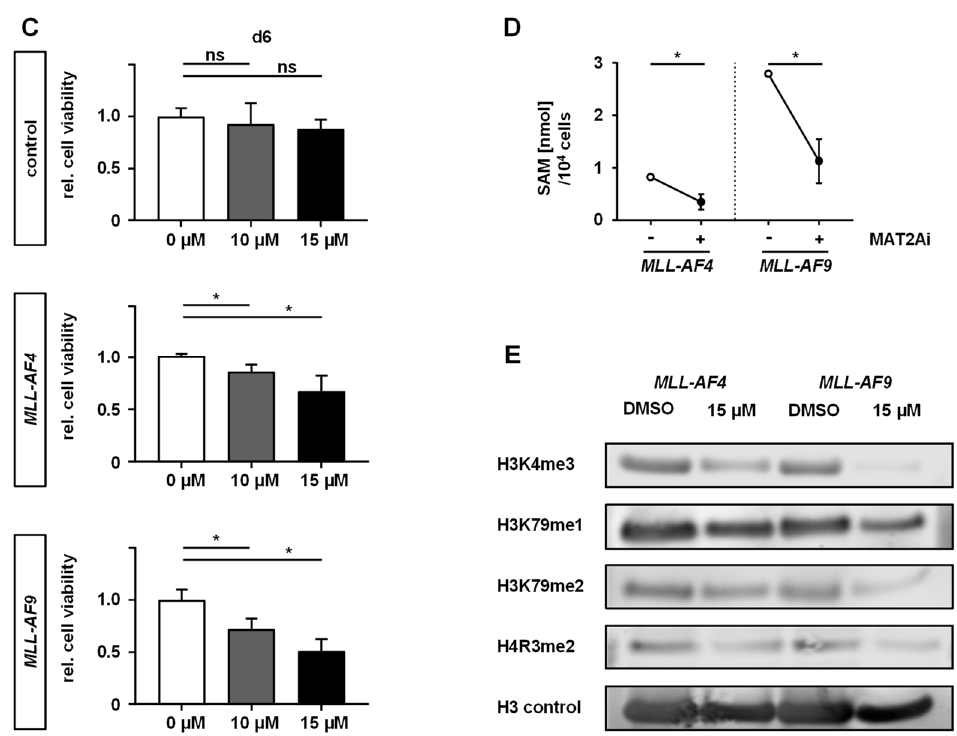
Figure 2. MAT2A inhibition impairs the proliferation and viability of MLL r cells, resulting in reduced SAM levels and histone methylation. ( A ) MLL-AF4 / -AF9 or culture-expanded CD34 + huCB control cells were treated with increasing concentrations of PF-9366 or vehicle (DMSO) for 6 days and the relative cell count was determined by flow cytometry using counting beads. Pooled data of three biological replicates ( n = 3) performed in technical triplicates are shown. IC 50 values of the dose–response curves were interpolated from a four-parameter logistic model constrained to 0 and 1 in GraphPad Prism. Dots represent the mean. Error bars indicate SD. One-way ANOVA was used with Dunnett correction: *, p < 0.05. ( B ) Proliferation curves were assessed by treating the indicated cells with PF-9366 (10, 15 µ M) or control (DMSO) and counting cells following Trypan blue staining every second day. The mean of pooled data of three biological replicates ( n = 3) performed in technical triplicates is shown. Dots represent the mean. Error bars indicate SD. One-way ANOVA was used with Dunnett correction: *, p < 0.05. ( C ) Cell viability of MLL r and control cells upon inhibition treatment with PF-9366 (10, 15 µ M) or control (DMSO) was determined after 6 days by fluorescence-based read of alamarBlue assay. Experiment was performed in three biological replicates ( n = 3) and technical triplicates. Bars represent the mean. Error bars indicate SD. One-way ANOVA was used with Dunnett correction: *, p < 0.05. ( D ) MLL r cells were treated with 15 µ M PF-9366 or DMSO as a control for 6 days. Intracellular SAM levels of 10 4 cells were quantified by fluorescence-based Bridge-It Assay Platform Technology using a SAM standard curve. Results of two independent experiments ( n = 2) are displayed. Student’s t -test was used: *, p < 0.05. ( E ) Western blot analyses of extracted histones from MLL r cells treated with 15 µ M or DMSO as the control for 6 days are displayed showing decreased global methylation of H3K4me3, H3K79me1, H3K79me2, and H4R3me2. Blots are cropped and full images are displayed in Figure